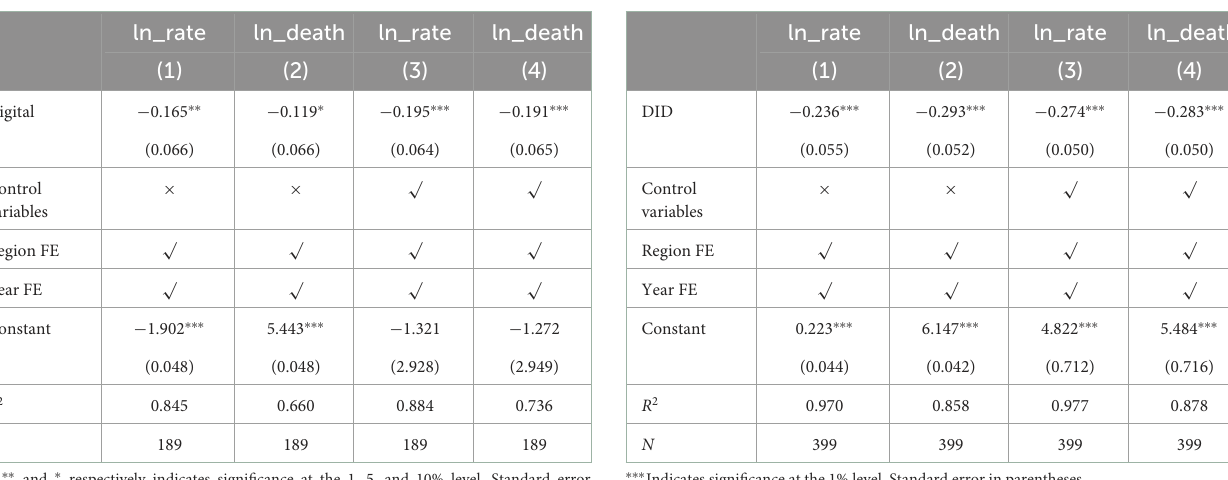
TABLE 3 Results of replacing the independent variable. TABLE 4 Results of controlling the impact of inherent city